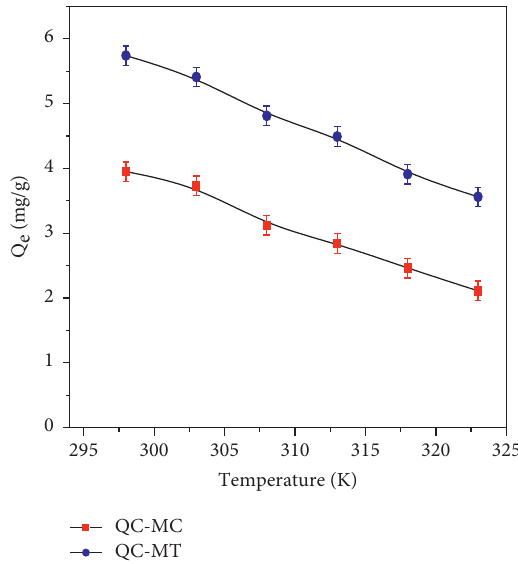
Figure 10: Effect of temperature on adsorption ( V � 100mL, C 0 � 10 mg/L, m � 1.5g pH � 5, and contact time � 30min for QC- MC and 45min for